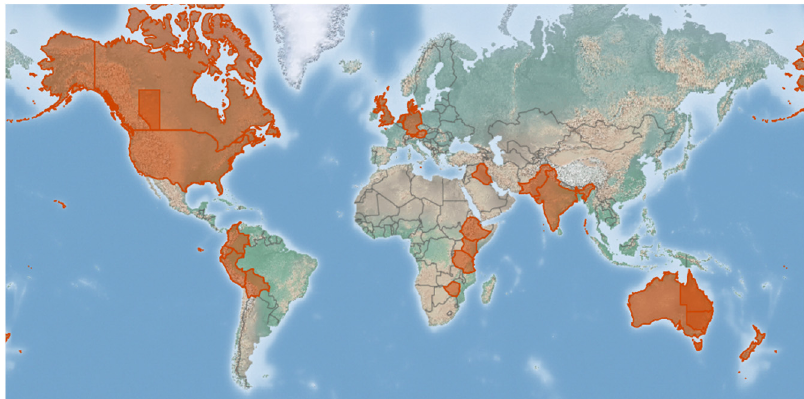
Figure 1. Downy mildew disease of Chenopodium spp. distribution map (CAB international, last modified 21 November 2019 via www.cabi.org/isc/datasheet/39704 (accessed 10 June 2021).